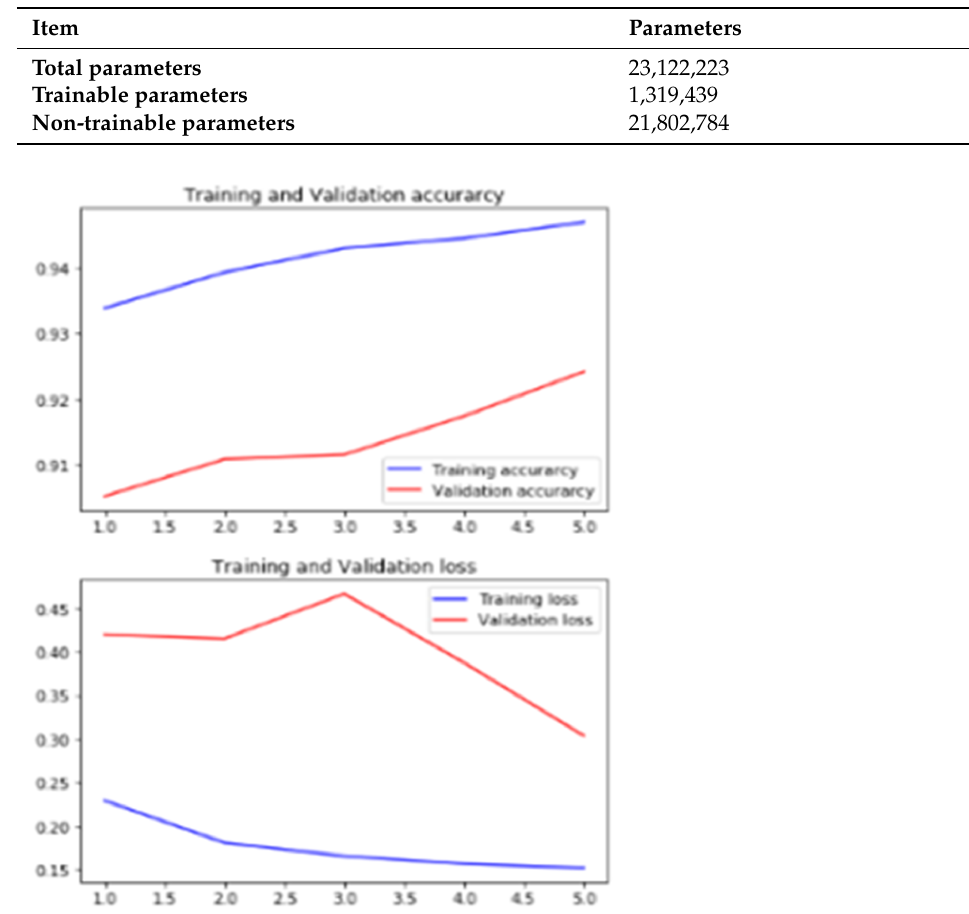
Table 2. INCEPTION V3 network model parameters.